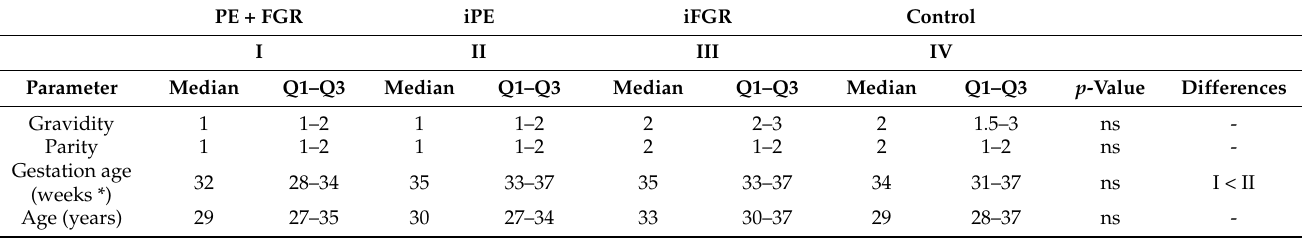
Table 1. Basic characteristics and statistical analysis of the study groups (based on results of